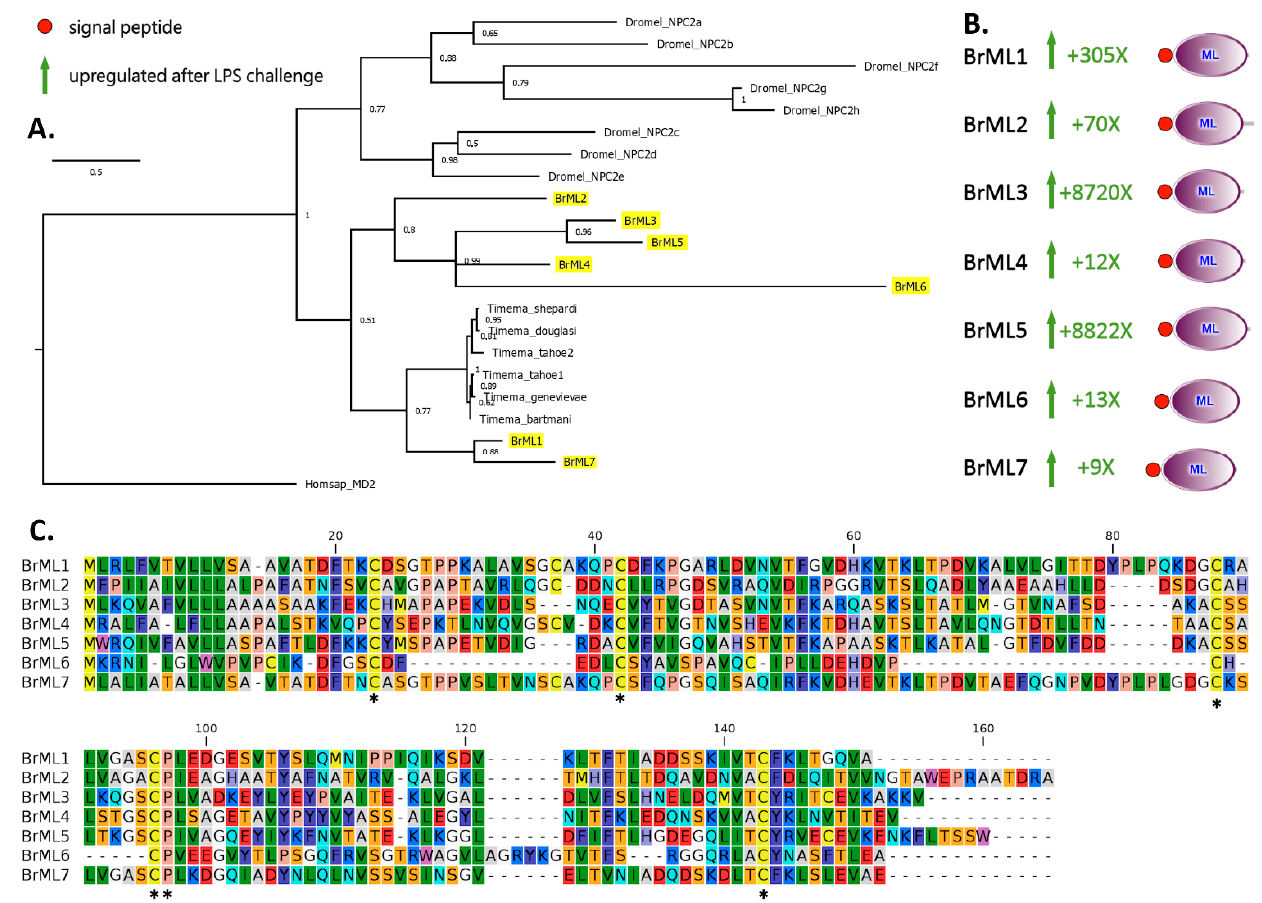
Figure 3. Bayesian phylogeny ( A ), domain architecture and gene expression trend following LPS stimulation ( B ), and multiple sequence alignment of B. rossius ML domain-containing proteins ( C ). The sequences from B. rossius are highlighted in yellow in the phylogenetic tree. Homsap: Homo sapiens ; Dromel: Drosophila melanogaster ; species name of the Tinema genus are expanded in the figure. The numbers shown close to each node represent posterior probability support values. Poorly supported nodes (i.e., <0.5) were collapsed. Asterisks indicate highly conserved residues in the MSA. The putative signal peptide of BrML6, which did not meet the significance threshold for being detected by SignalP, is indicated by a dashed circle.